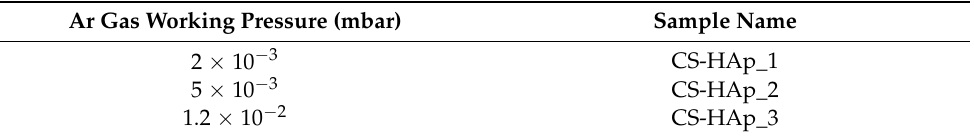
Table 1. Ar working pressure and the associated name of the obtained